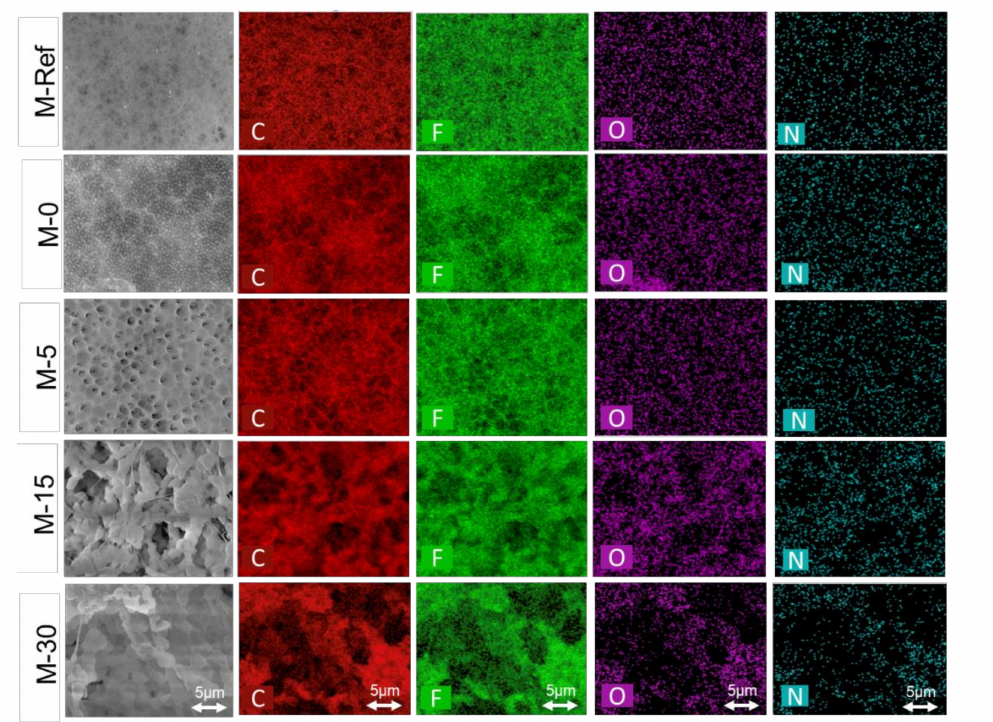
Figure 7. EDX mapping for main elements (C, F, O, and N) present in the resulting membranes.